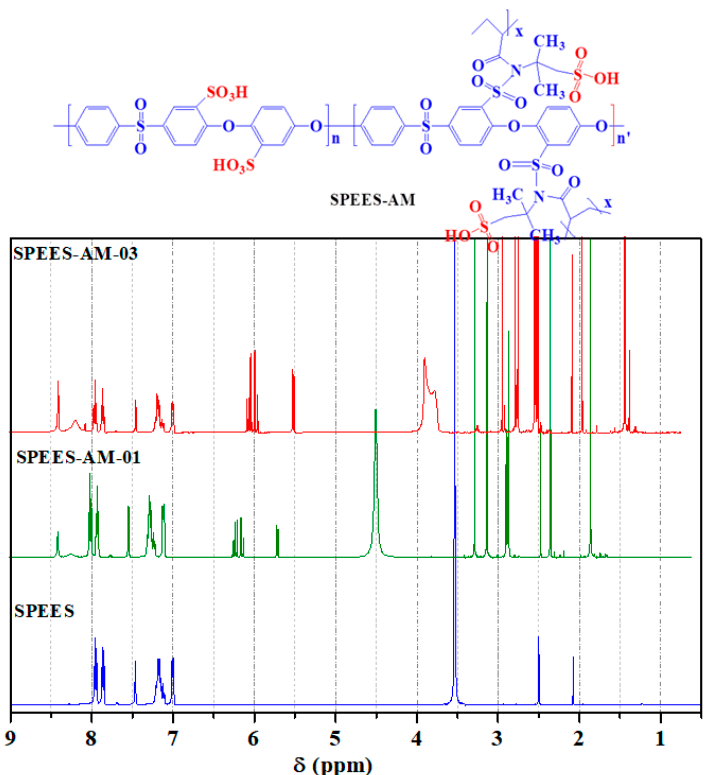
Figure 1. 1 H NMR for SPEES, SPEES-AM-01, and SPEES-AM-03.